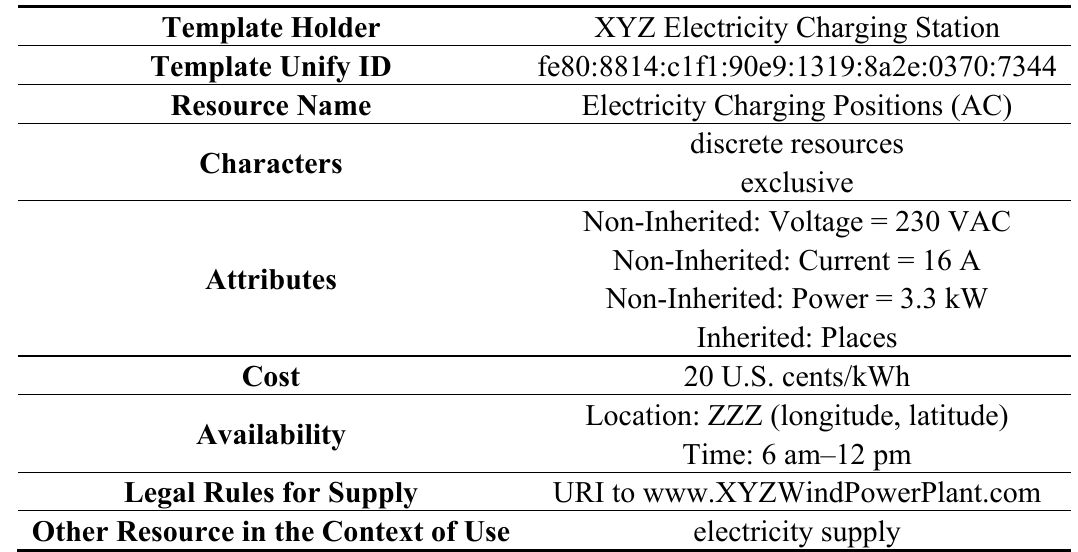
Table 4. RSDT published by an electricity charging station.